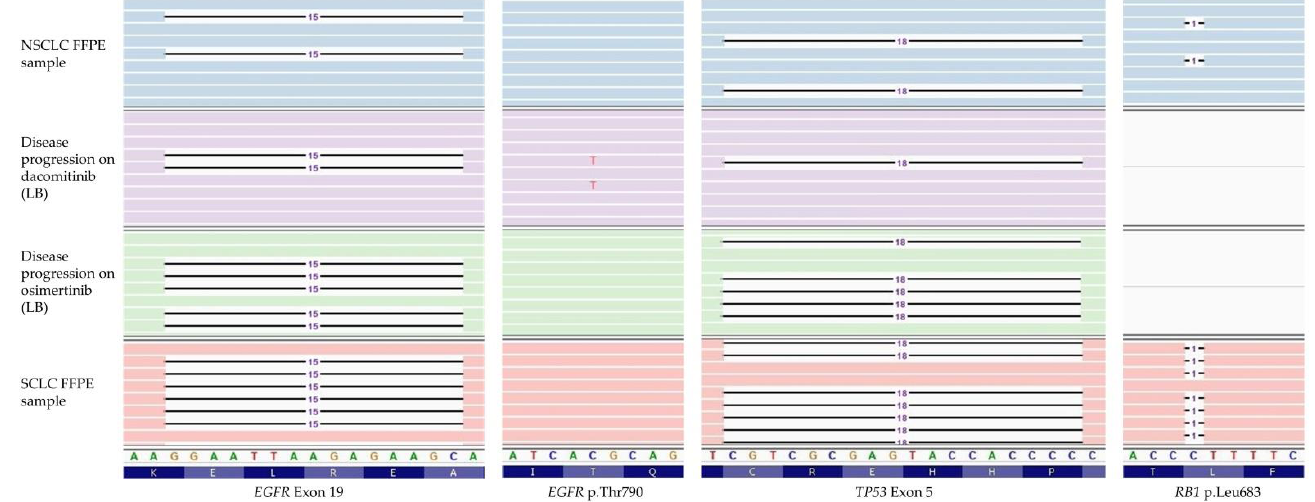
Figure 1. Integrative Genomics Viewer (IGV) browser visualization of the NGS results in the genomic positions, which became relevant for clinical management. For each sample and gene, colored bars represent the reads aligned along the reference genome (the RB1 gene was only covered in the NGS studies of FFPE samples). Mismatched nucleotides are labeled. Black horizontal lines represent the nucleotides that have been deleted. Table 1. Variant allele frequencies of the EGFR , TP53 and RB1 variants detected in NGS studies.